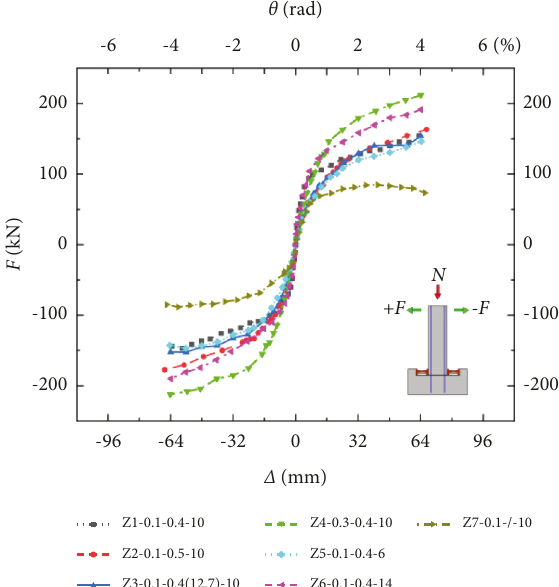
Figure 14: Comparison of skeleton curves